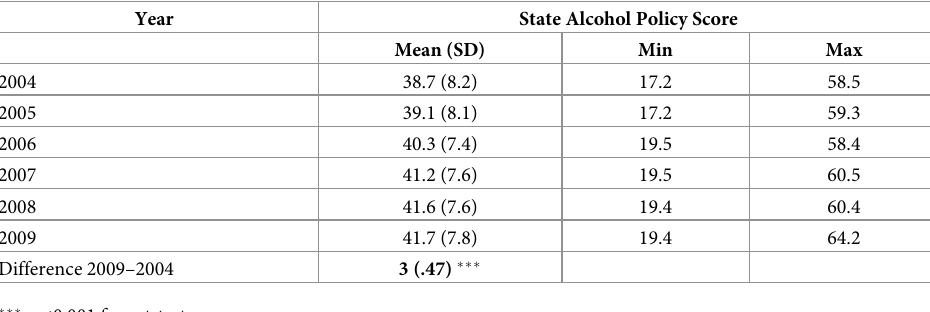
Fig 2 presents predicted probabilities from the full model. For each race/ethnicity category, lower SAPS scores are associated with higher probability of binge drinking. This probability declines as the SAPS increases in strength. The probability of any binge drinking is higher for males in each group, but there are important sub-group differences in the highest and lowest rates as well as the gap between men and women. An increase in the state SAPS from 0 to 10 would be associated with a 30% to 18% reduction in binge drinking among the group with the Table 1. Mean State Alcohol Policy Score (SAPS) by year